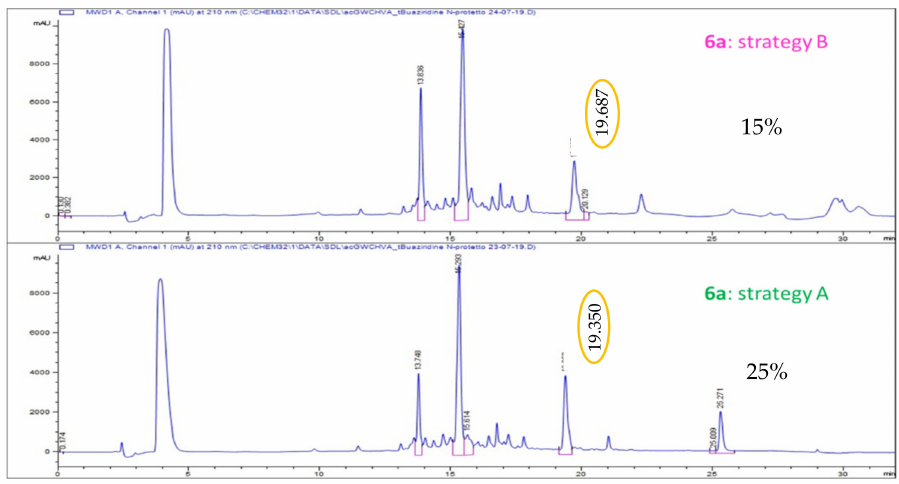
Figure 2. Superposition of the HPLC spectra of compound 6a obtained from the aziridine precursor with strategy A (MW irradiation) and strategy B (T =